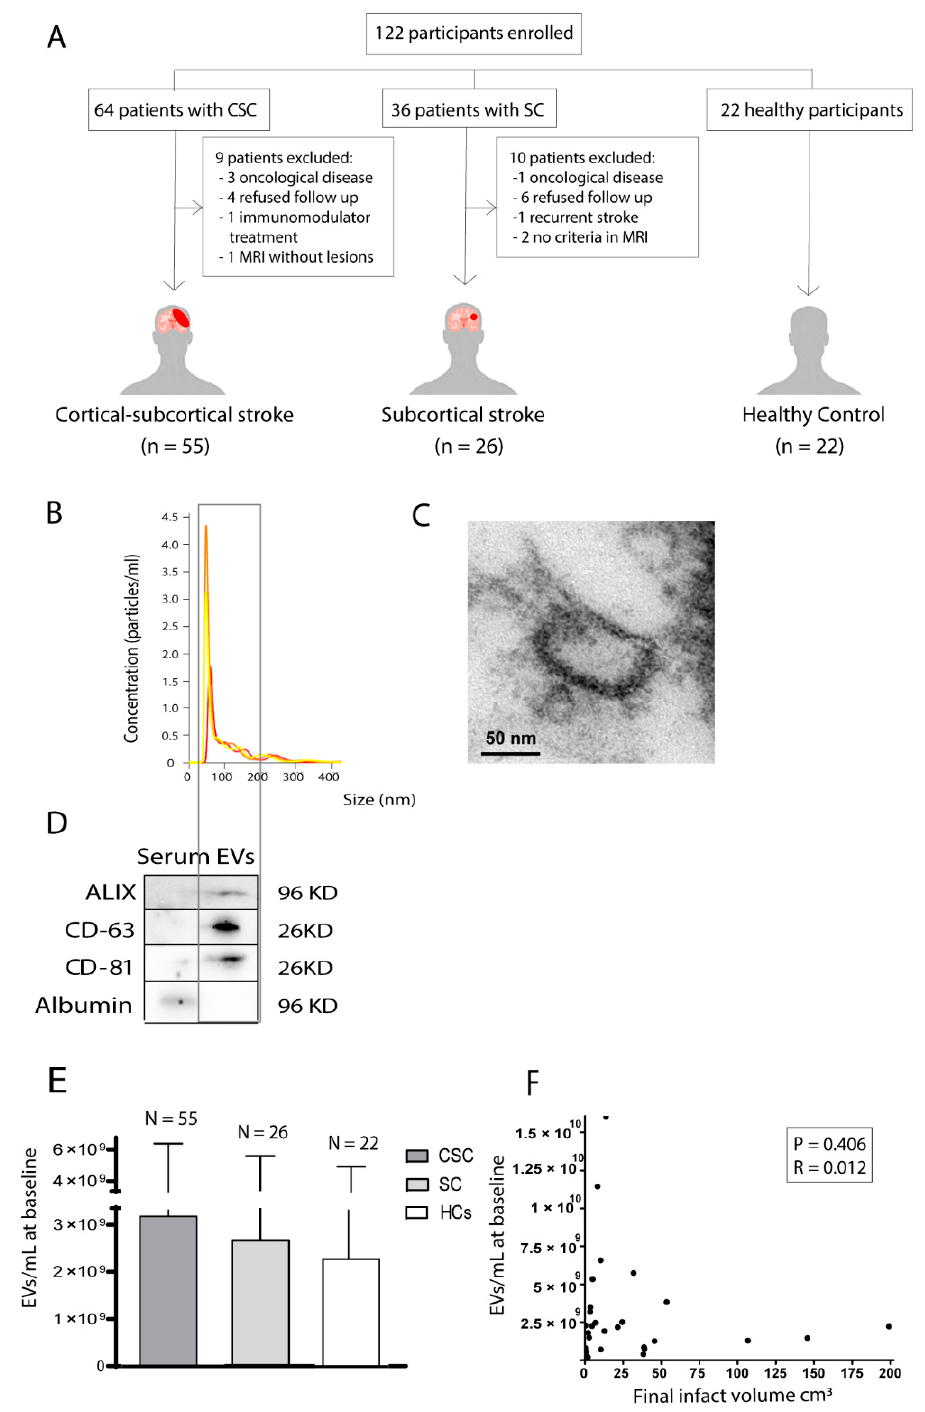
Figure 1. Participants, EV characterisation, and EV levels: ( A ) number of patients enrolled in the study; ( B ) characteristics of EVs. Size and concentration of the particles detected in the sample EVs isolated from HCs by NanoSight; ( C ) electron microscope image. EVs from HCs smaller than 100 nm were observed by electron microscope; ( D ) Western blot. Detection of EVs from HCs with specific markers (positive: Alix, CD63 and CD81; negative: Albumin) by Western blot. Negative control samples are serum. The gel image was cropped; ( E ) EV levels at 24 h showed no differences between the CSC, SC, and HC groups; ( F ) correlation between EV levels and total infarct volume. Data are expressed as mean ± SD. Abbreviations: CSC, cortical-subcortical stroke; EVs, extracellular vesicles; HCs, healthy controls; SC, subcortical stroke. The samples were run after only one freezing.